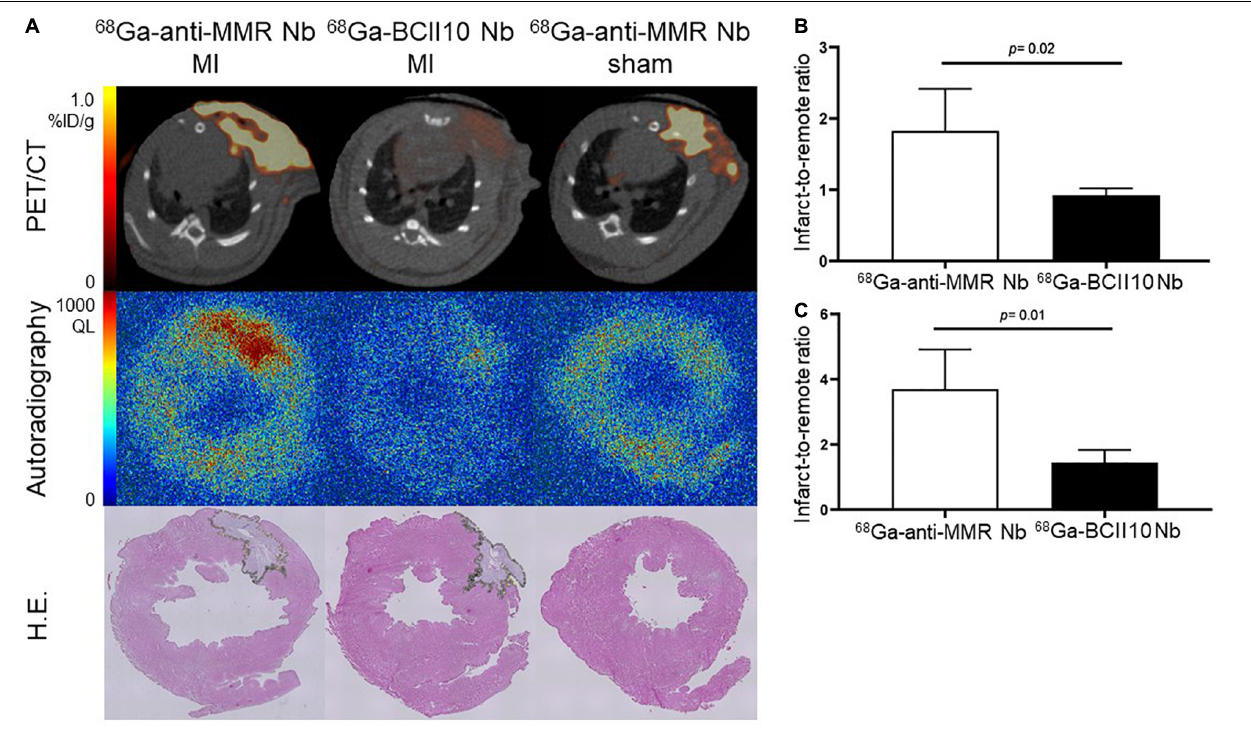
FIGURE 5 | Binding specificity test in rats. (A) In vivo (PET/CT) and ex vivo (autoradiography) evaluation of targeting 68 Ga-NOTA-anti-MMR Nb and non-targeting 68 Ga-NOTA-BCII10 Nb biodistribution in infarcted (7 days after coronary ligation) and non-infarcted (sham-operated) rat hearts and corresponding H.E. staining. (B) PET image-derived and (C) autoradiography image-derived infarct-to-remote area uptake ratios derived from n = 4 MI rats injected with 68 Ga-NOTA-anti-MMR Nb and n = 4 MI rats injected with 68 Ga-NOTA-BCII10 Nb. QL = quantum